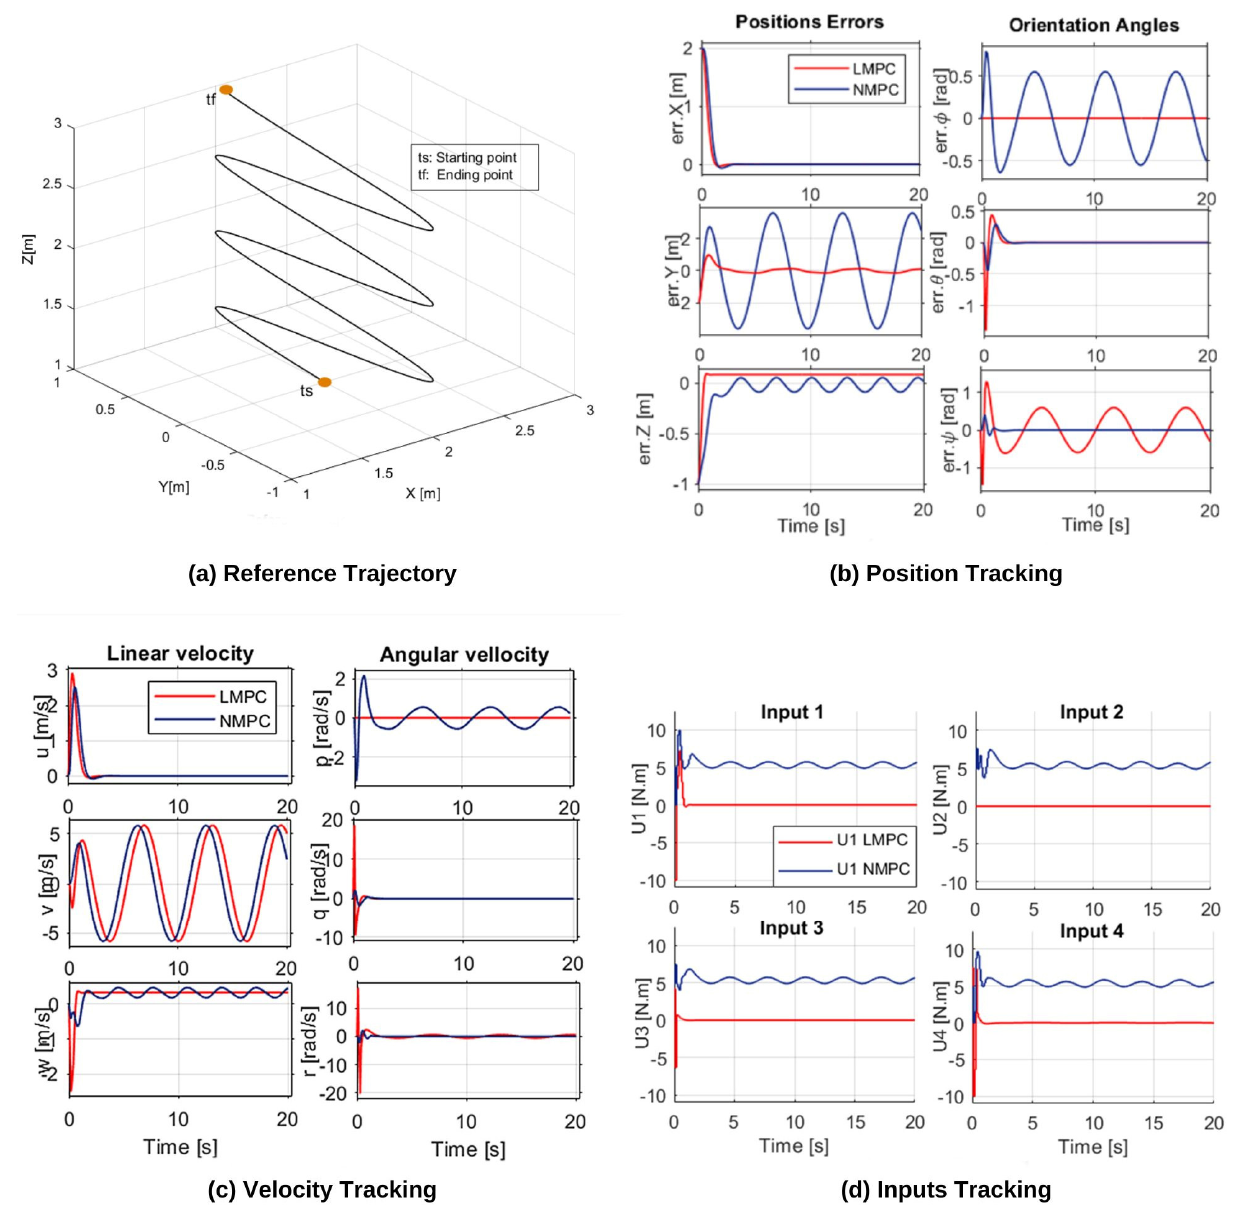
Figure 9. Straight curvature trajectory. Table 5. Calculation of the average control effort value and the execution